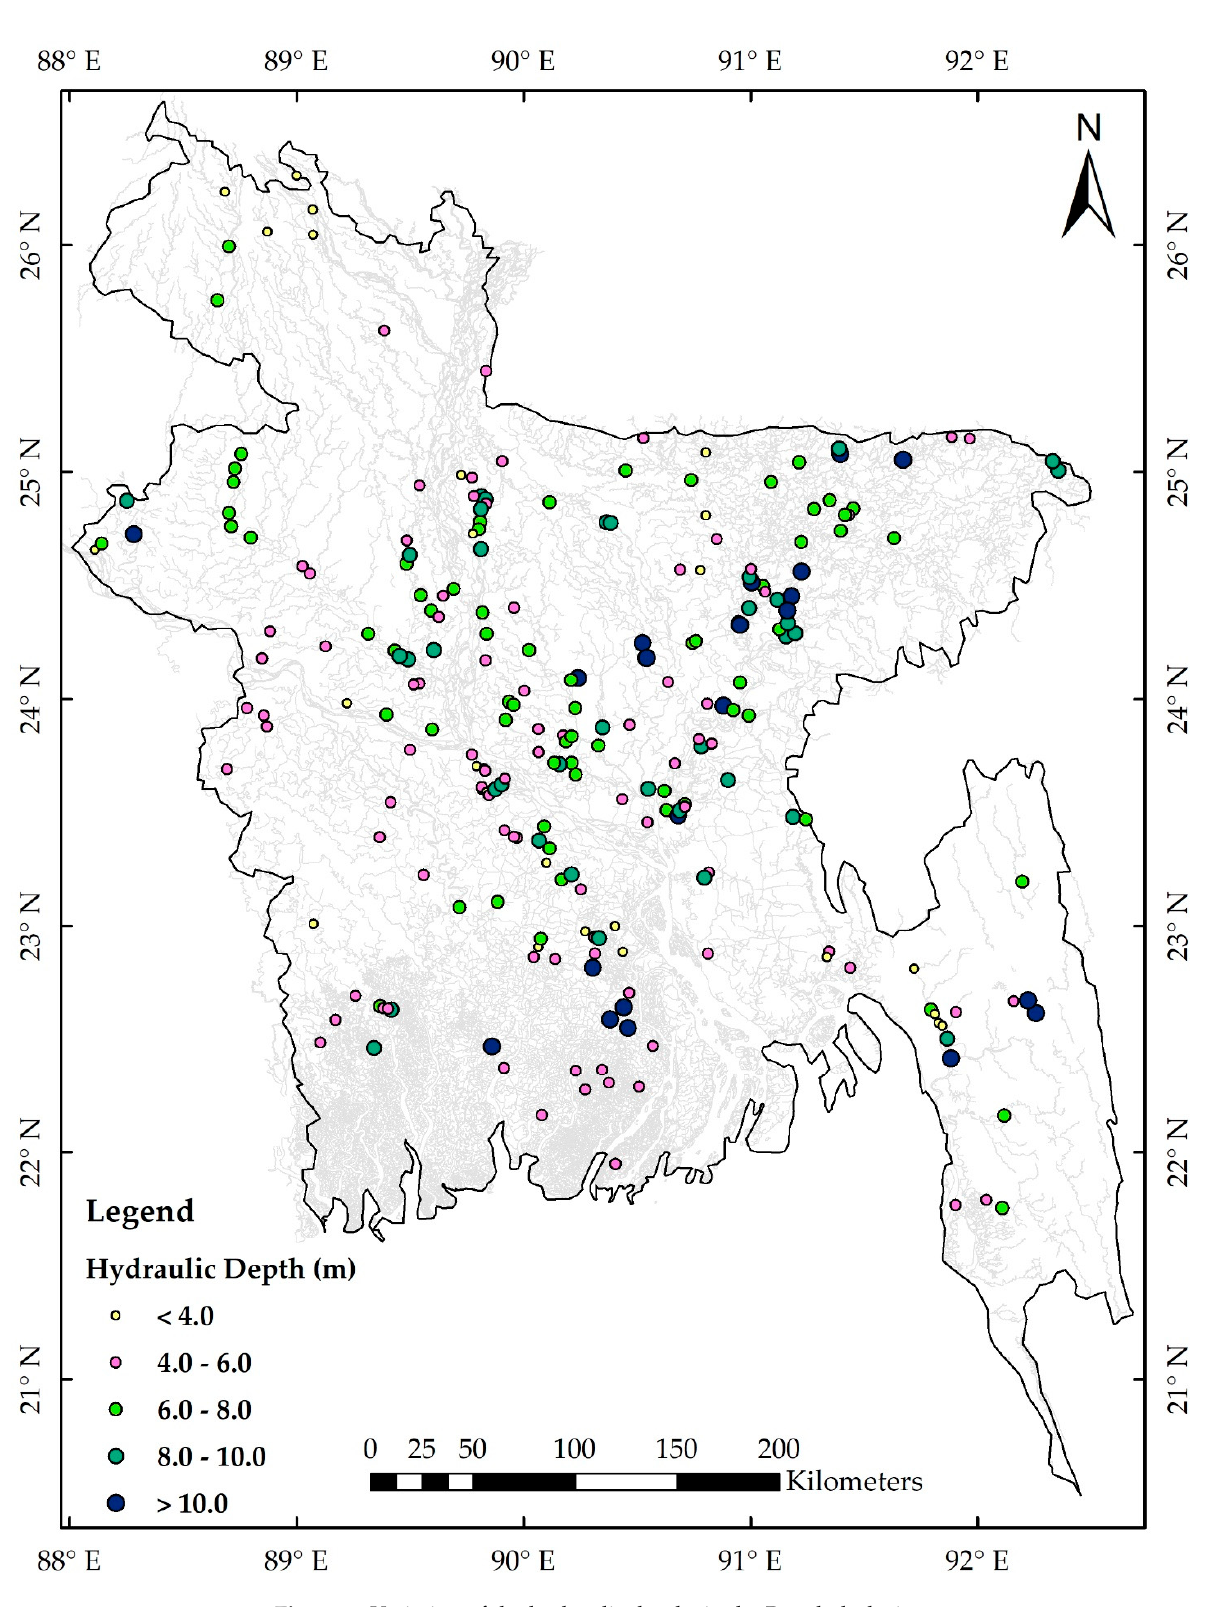
Figure 2. Variation of the hydraulic depths in the Bangladesh rivers.